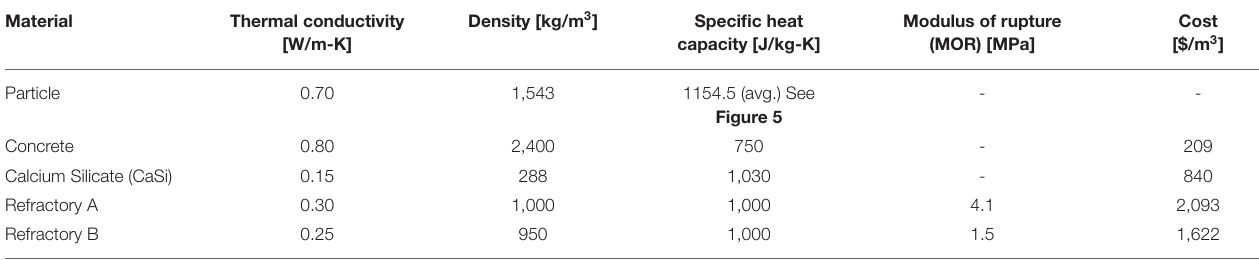
TABLE 1 | Relevant material properties and cost of the materials used in the models. Material